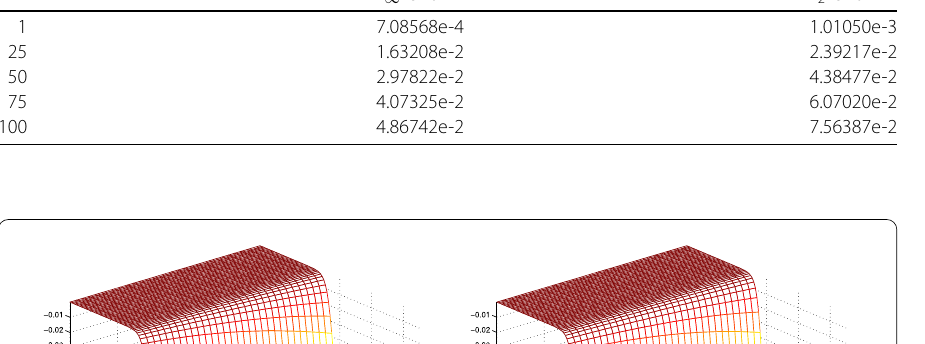
Table 2 The errors at various time of NSFD scheme (39) with (cid:3) t = h 2 = 0.25 T L ∞ -error L 2 -error